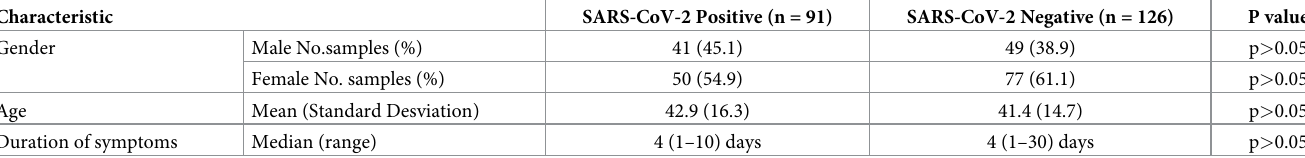
Table 1. Characteristics of the study population based on the SARS-CoV2 status. Characteristic SARS-CoV-2 Positive (n = 91) SARS-CoV-2 Negative (n = 126) P value Gender Male No.samples (%) Female No. samples (%) Age Duration of